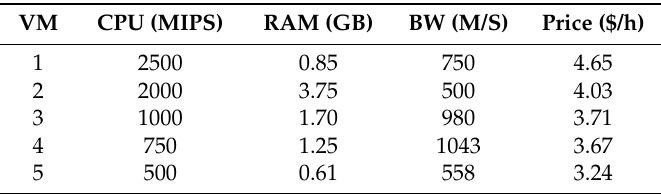
Table 2. Five kinds of virtual machine (VM)